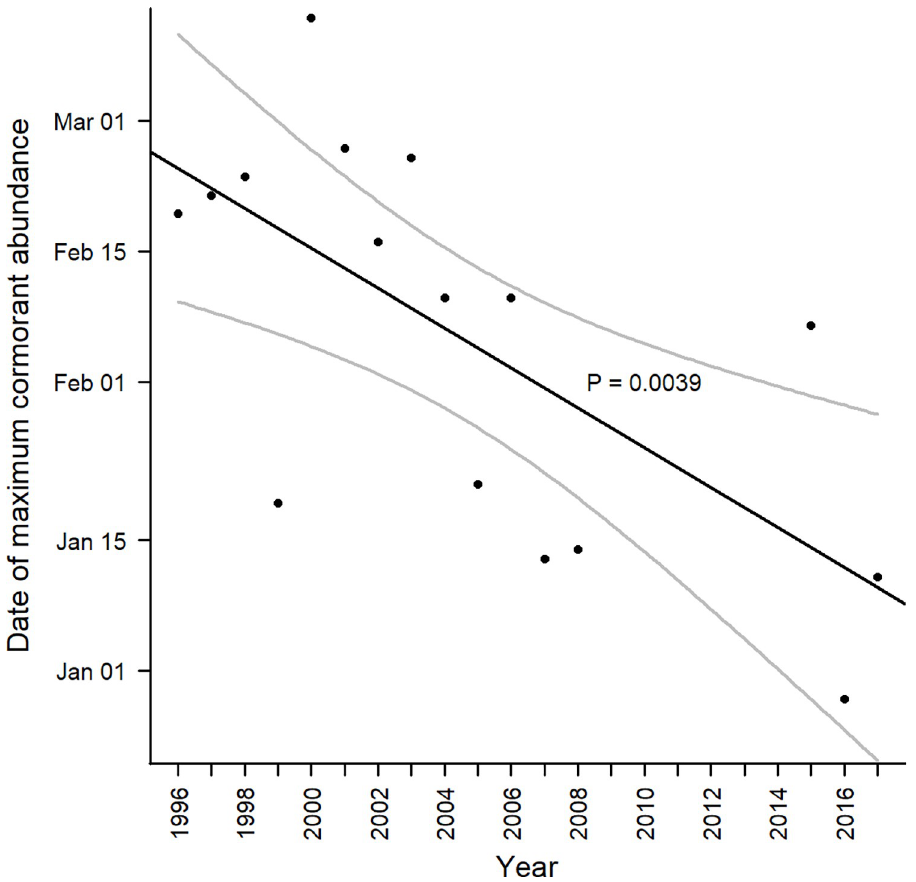
Fig 9. Trend in maximum cormorant abundance in the Mississippi Delta from 1996 through 2017. Dates were estimated from polynomial equations constructed for each year of available data (Fig 8). The black line (+ 95% CI gray lines) represents the significant linear relationship between variables, with a -2.14